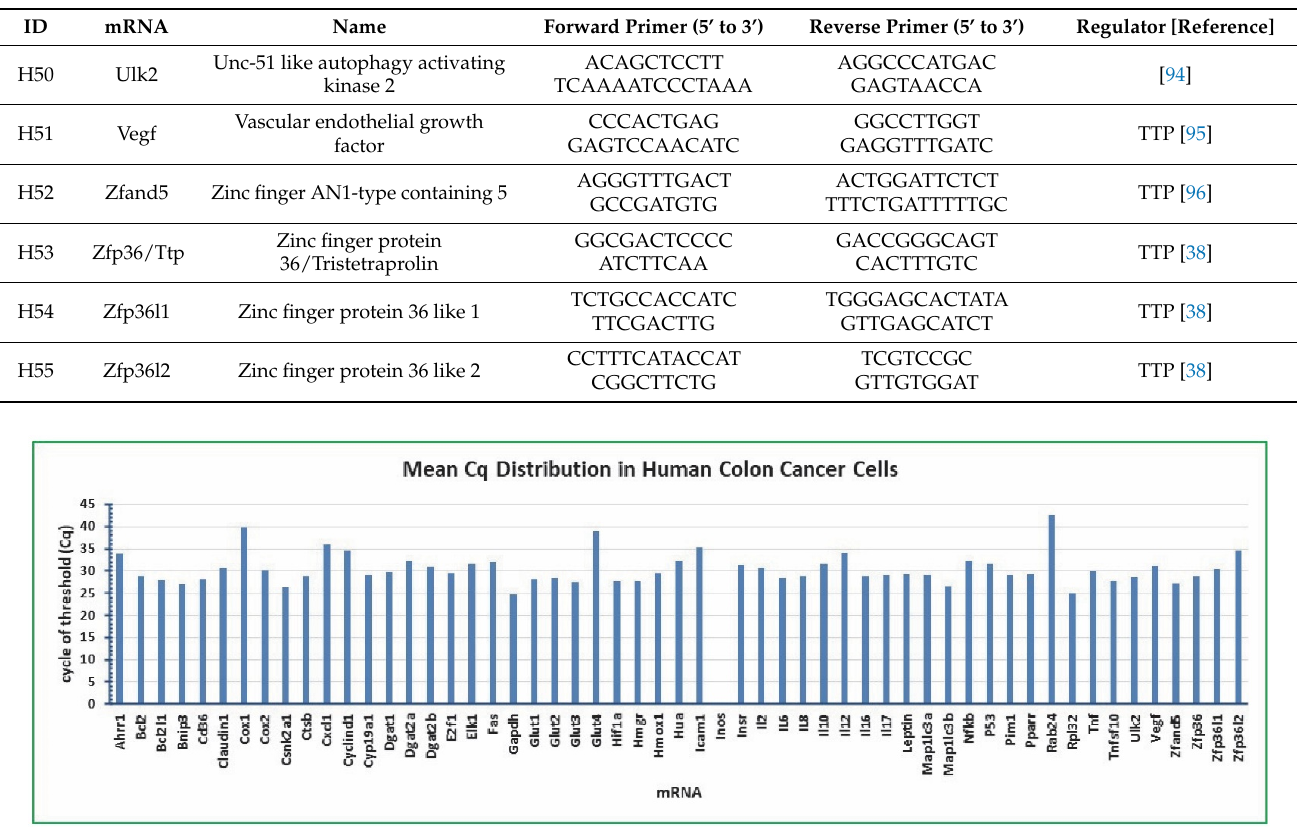
Figure 2. Mean Cq distribution of 55 mRNAs in human colon cancer cells. The cancer cells were treated with multiple concentrations of gossypol (0, 0.1, 0.5, 1, 5, 10, 50, and 100 µg/mL), LPS (0, 5, 10, 20, 50, 100, 500, and 1000 ng/mL) and cottonseed extracts (0, 5, 10, 20, 30, 40, 50, and 100 µg/mL) for 8 h and 24 h. Total mRNAs were extracted from the cells, converted into cDNAs, and the relative abundance was analyzed by SYBR Green qPCR. The Cq values represent the mean of 192 independent